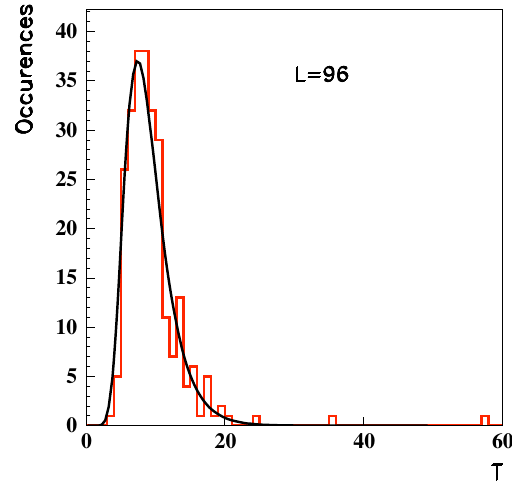
Fig. 8 The distribution of the test statistic calculated in the 256 sets of 96 samples, compared to the expected distribution for L = 96 statistic found in one of our runs was 2 × 10 − 5 taking L =